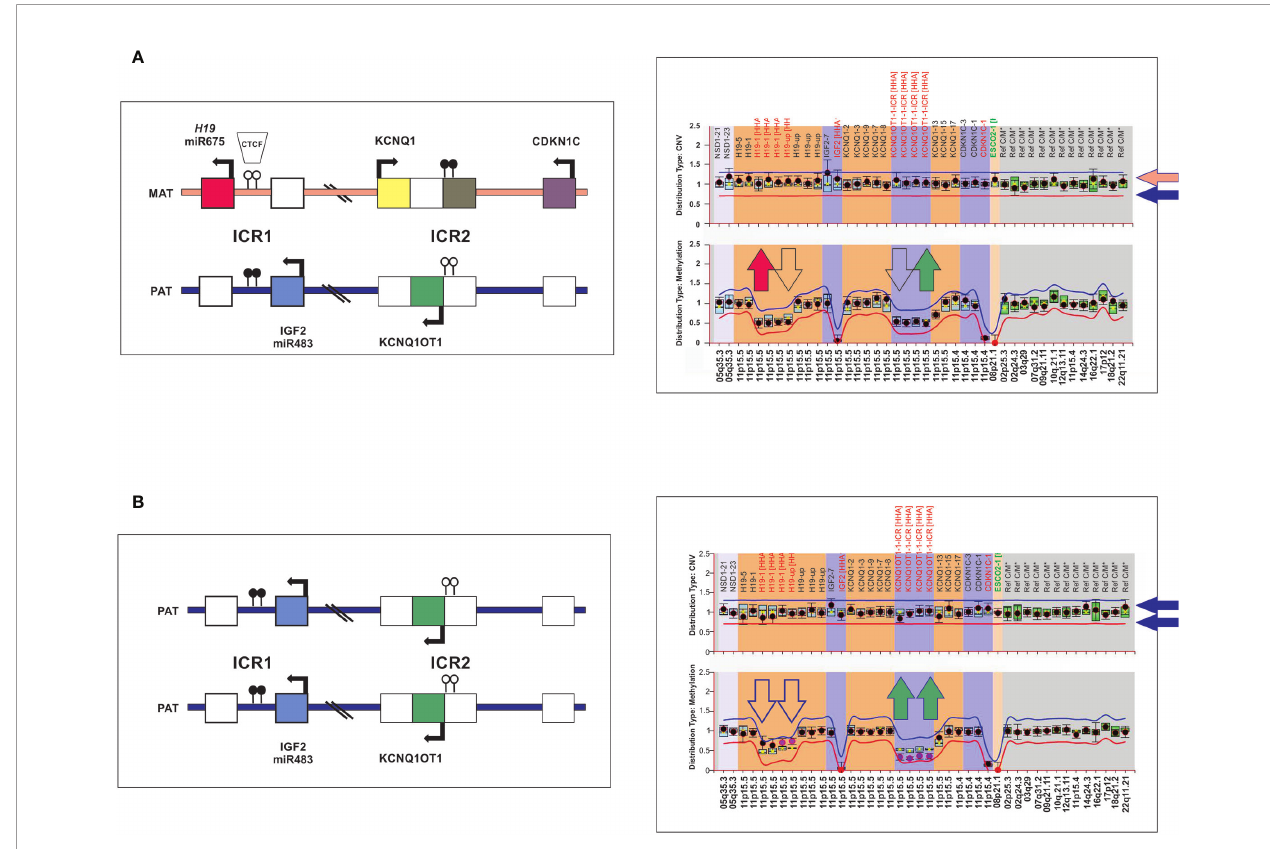
FIGURE 2 | Schematic representation of the chromosome 11p15 covered by the MS-MLPA assay. (A) The left panel shows a diagram of the imprinted gene cluster on chromosome 11p15 with normal chromosomal copy number and methylation status. The right panel, MS-MLPA showing a diploid content of chromosome 11p15 (upper panel) and ICR1 and ICR2 for methylated probes (lower panel) in the normal range, consistent with the presence of maternal and paternal chromosomes 11p15. (B) Individuals with paternal 11p15 UPD as visualized by MS-MLPA. ICR1 hypermethylated and ICR2 hypomethylated consistent with loss of maternal chromosome